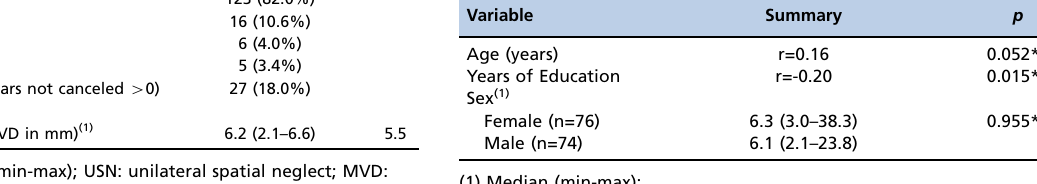
Table 3 - Association between deviations from the center obtained in the line bisection and demographic variables. Variable